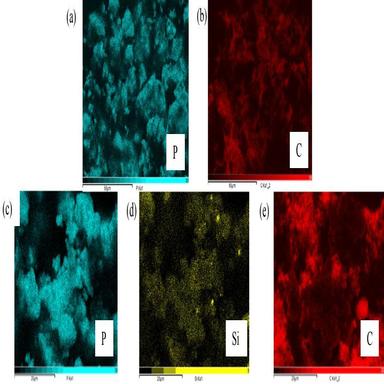
EDS Mapping from electrode sheets of LiFeSixP1-xO4/C with x = 0 on (a) P; (b) C; and x = 0.05 on (c) P;(d) Si; and (e) C